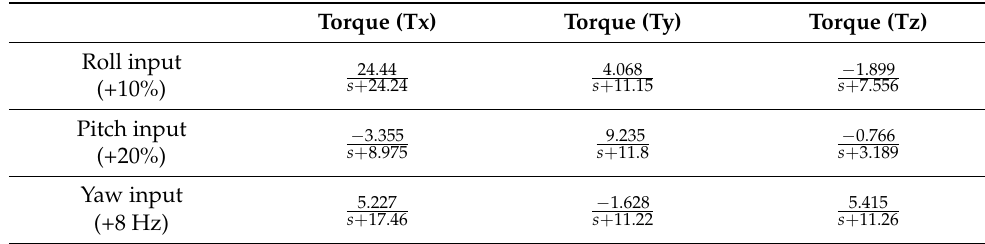
Table 3. Transfer function for each normalized